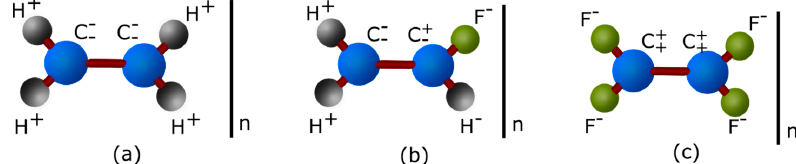
Figure 1. Polyethylene apolar molecule ( a ); poly(fluoroethylene) polar molecule ( b ); and poly(tetrafluoroethylene) apolar molecule because of its symmetry ( c ).